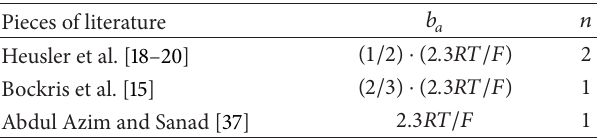
Table 3: Kinetic parameters of typical mechanisms for iron dissolu- tion